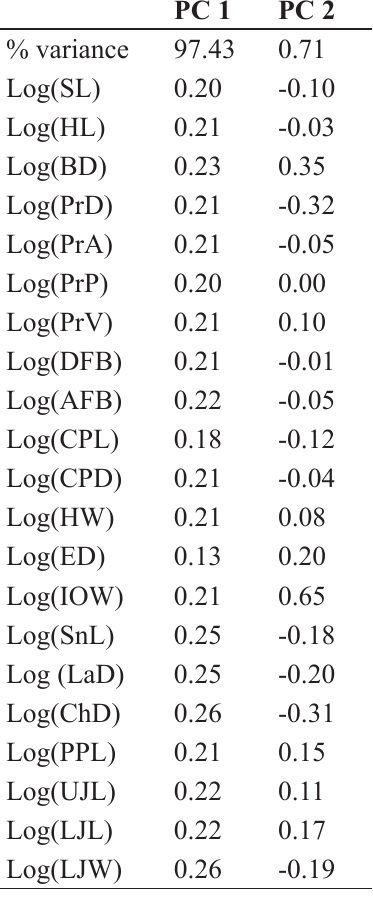
Table S3. PCA loadings of 21 log-transformed measurements from: H . rex sp. nov., H . simba sp. nov., and H . glaucus sp. nov. Results illustrated in Fig. 3c. Abbreviations: SL = standard length; HL = head length; BD = body depth; PrD = predorsal distance; PrA = preanal distance; PrP = prepectoral distance; PrV